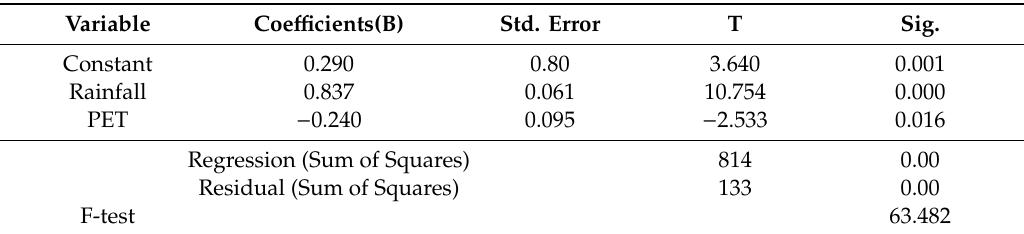
Table 6. Impact of rainfall and potential evapotranspiration on runo ff coe ffi cients.